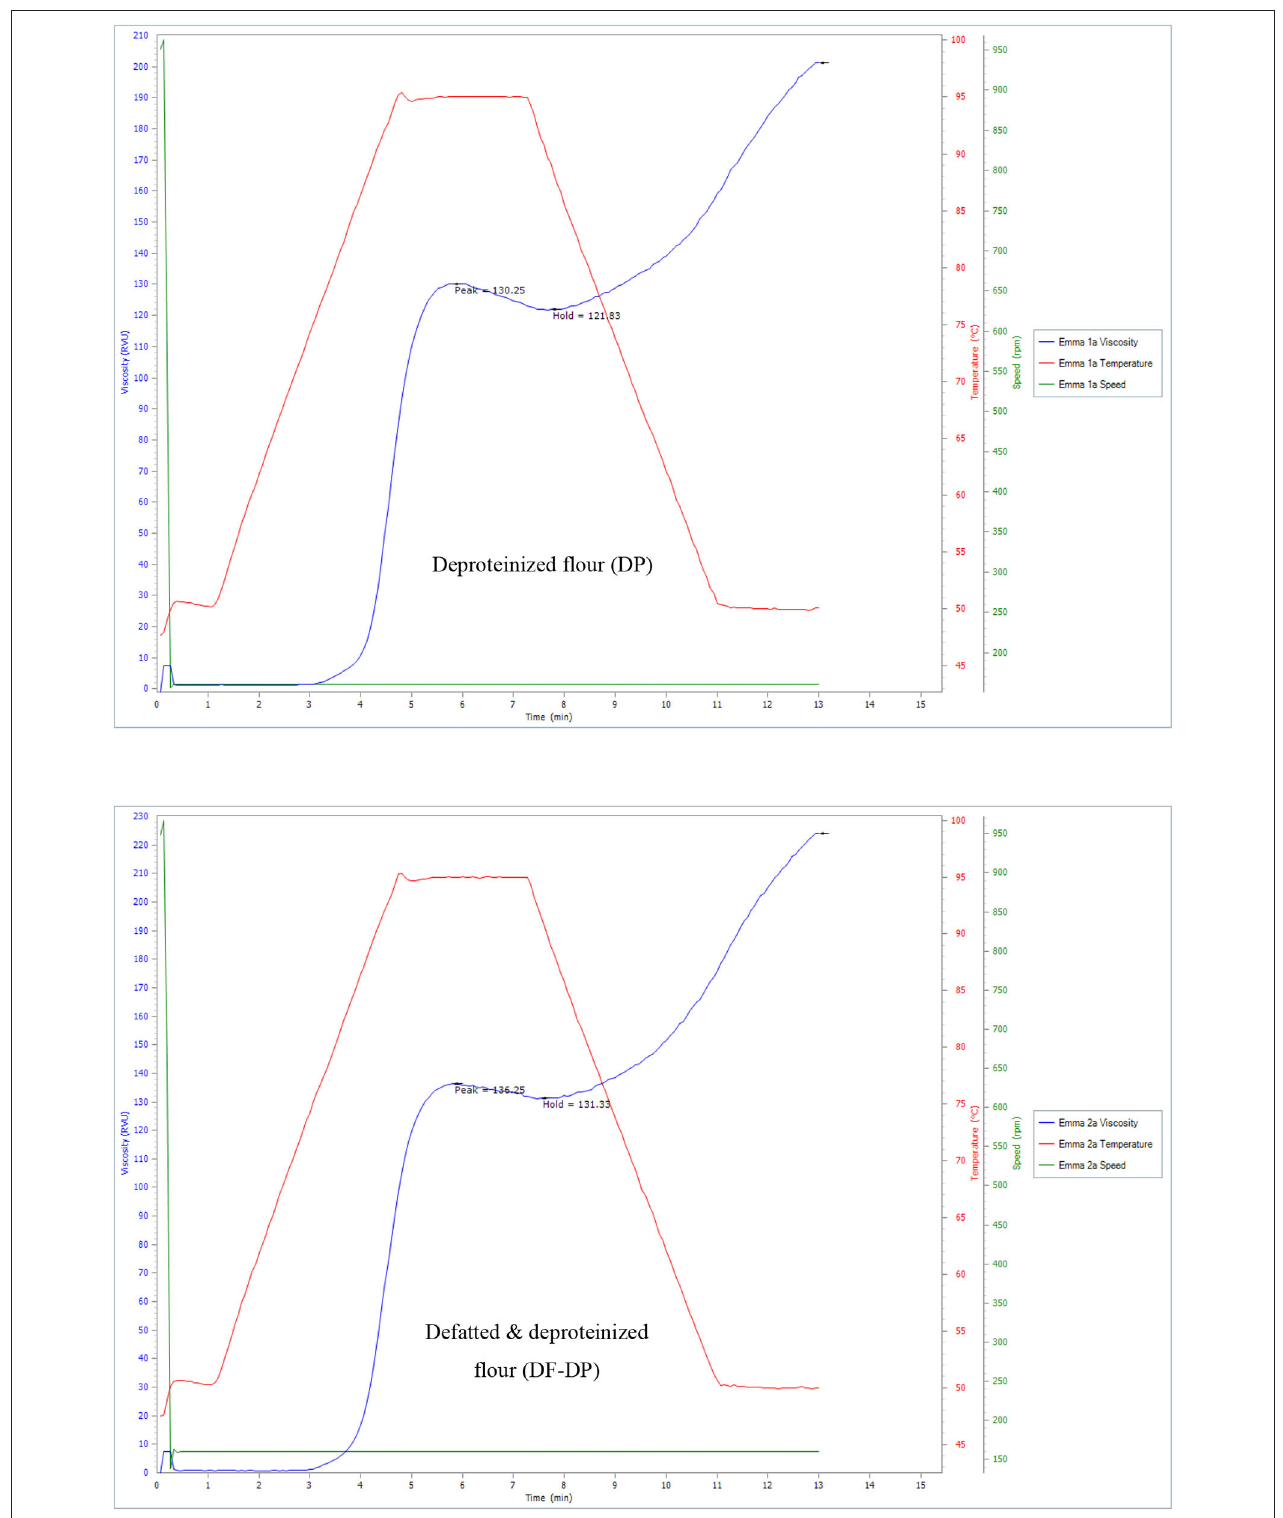
FIGURE 1 | Representative amylographs of control (SF), defatted (DF), deproteinized (DP), and defatted and deproteinized (DF-DP) red sorghum flour samples.